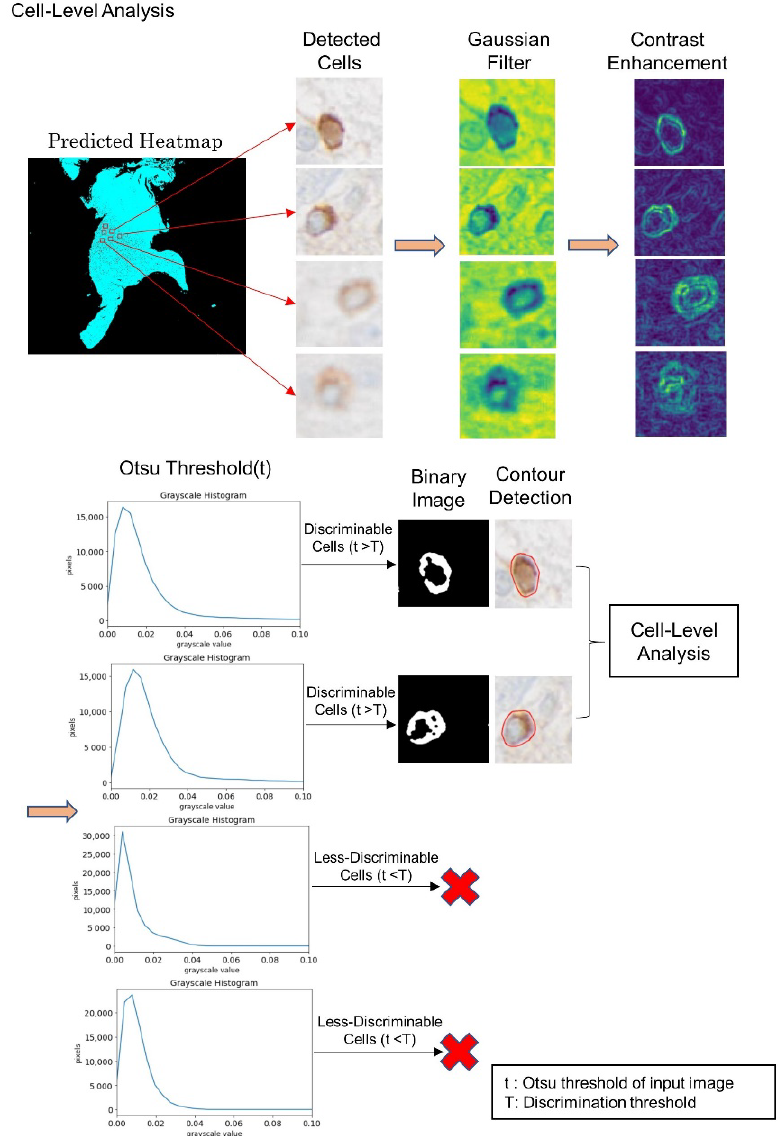
Figure 2. Cell-level analysis. Image patches containing cells identified by the BCNN are then processed for cell-level analysis. Filtering and thresholding are followed by edge and contour detection. An image is considered discriminable if the minimum acceptance value for the Otsu threshold is reached. It can then be segmented using edge and contour